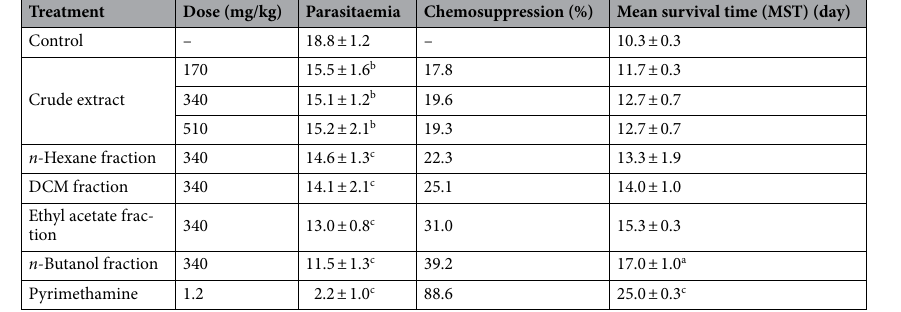
Table 3. Prophylactic activities of leaf extract and fractions of S. officinarum. Values are expressed as mean ± SEM. Significance relative to control. a p < 0.05; b p < 0.01; c p < 0.001 (n = 6).